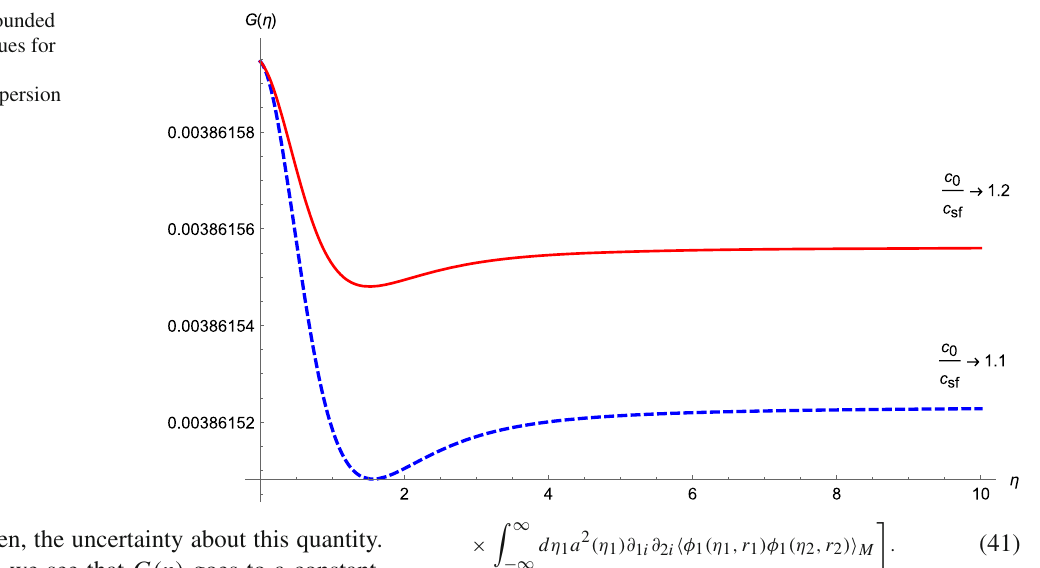
Fig. 1 Dispersion for bounded particles for different values for the sound speed and β = 3 . 6 × 10 − 8 . The dispersion decreases when LIV is